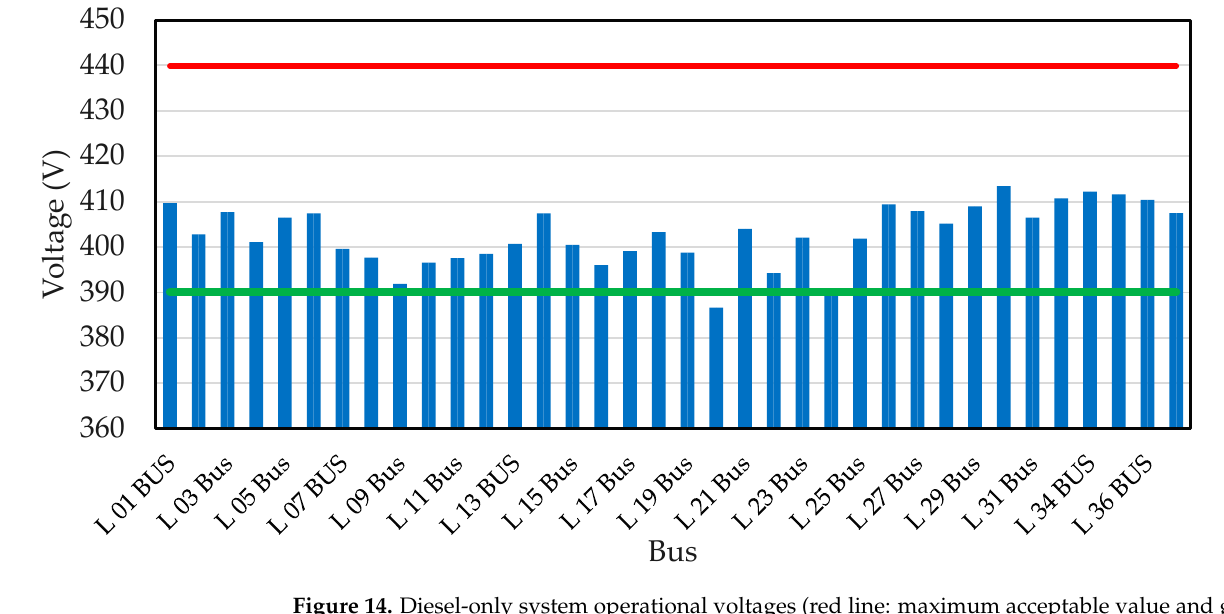
Figure 14. Diesel-only system operational voltages (red line: maximum acceptable value and green line: minimum acceptable value) at different load bus during the summer load.